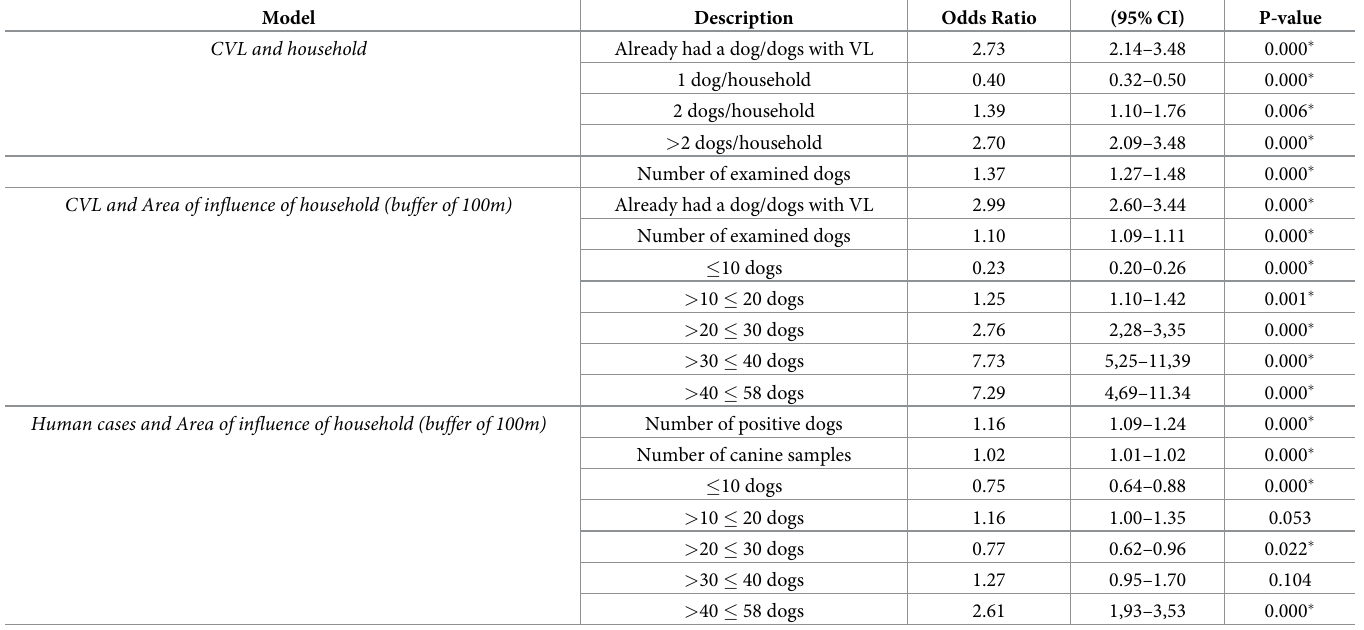
Table 2. Binary logistic regression of canine visceral leishmaniasis diagnostic, dog count in the buffer zone extraction versus the number of positive dogs and human cases in